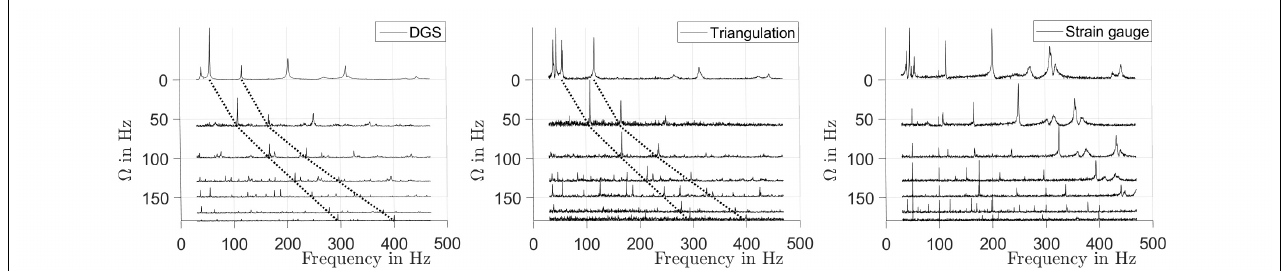
Figure 6. Waterfall plots of surface tilt measurement with the DGS, axial displacement measurement with triangulation and strain gauge at one location on the rotor. For the DGS and the triangulation sensor, an FRF of a location at r = 237 mm is shown. The strain gauge was placed at R = 170 mm. The dotted lines indicate the peaks of the second and third tangential modes, as plotted in Figure 7.